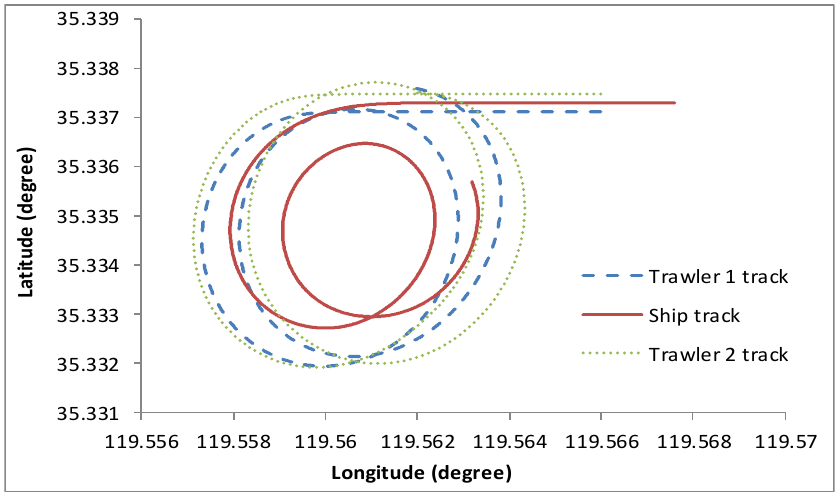
Figure 13. Rotation track of towing system under the action of wind power.